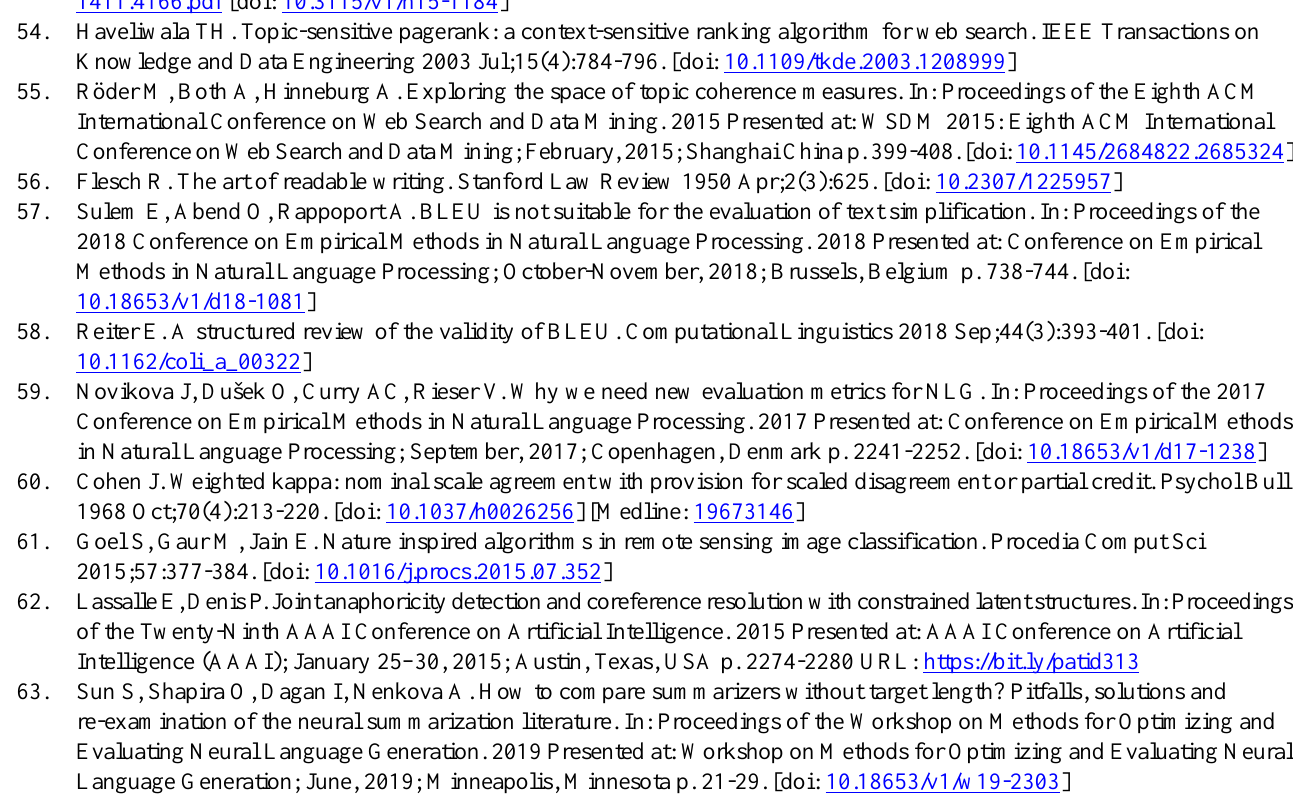
AoES: abstraction over extractive